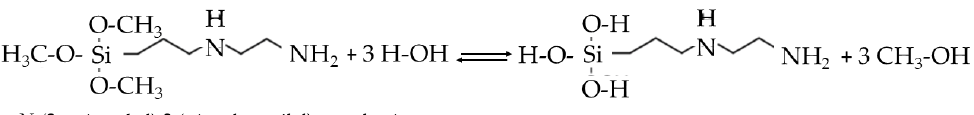
Figure 3. Hydrolysis of ORMOSIL.